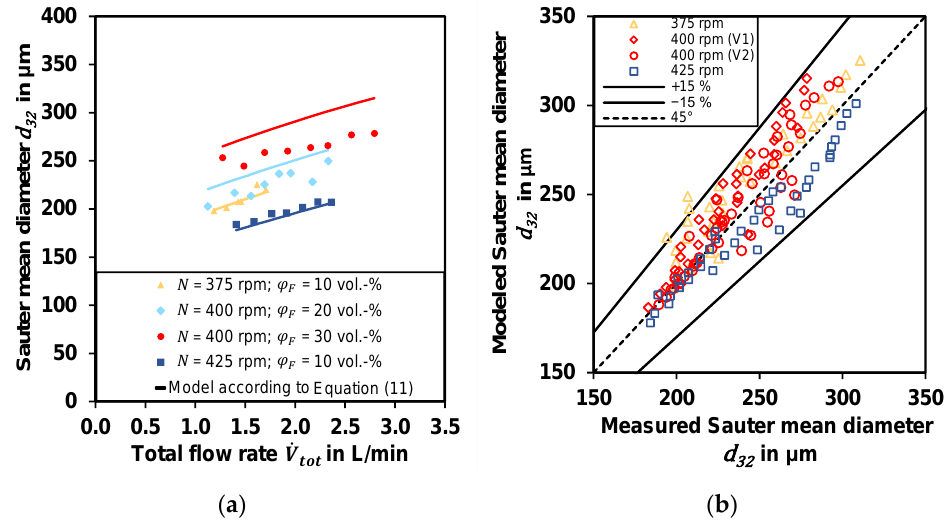
Figure 13. ( a ) Experimental data and Equation (11) as solid line. ( b ) Parity plot of all experiments versus Equation (11).